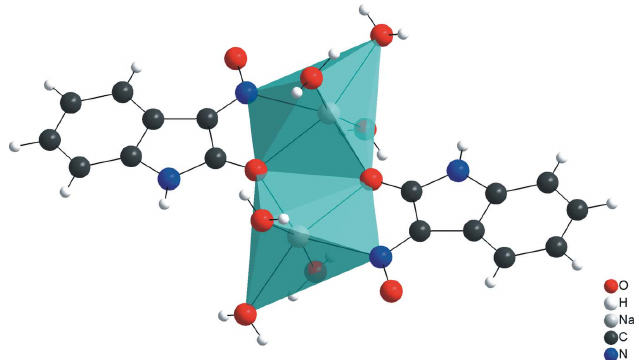
Figure 8 Partial view of the structure of catena-poly[[[aquasodium]-di- (cid:4) -aqua- [aquasodium]-bis( (cid:4) -2-oxoindoline-2,3-dione 3-oximato)] tetrakis(- oxoindoline-2,3-dione 3-oxime)].